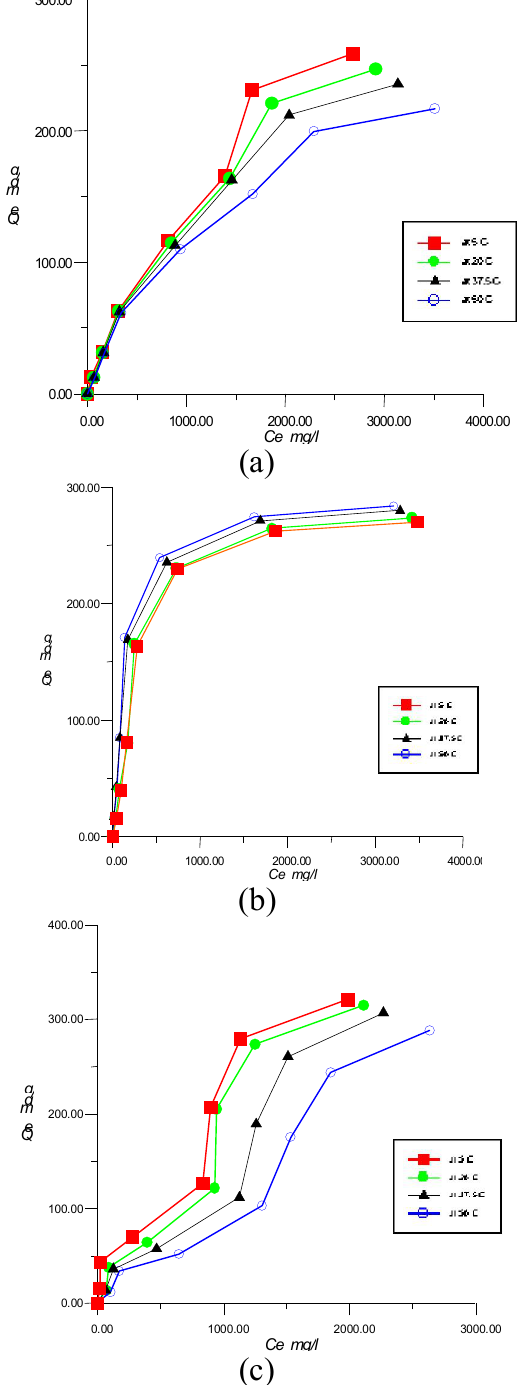
Figure 1: Adsorption isotherms of (a) amitriptyline HCl (b) chlorpromazine HCl (c) chlordiazepoxide HCl on bentonite at (5, 20, 37.5, and 50 o